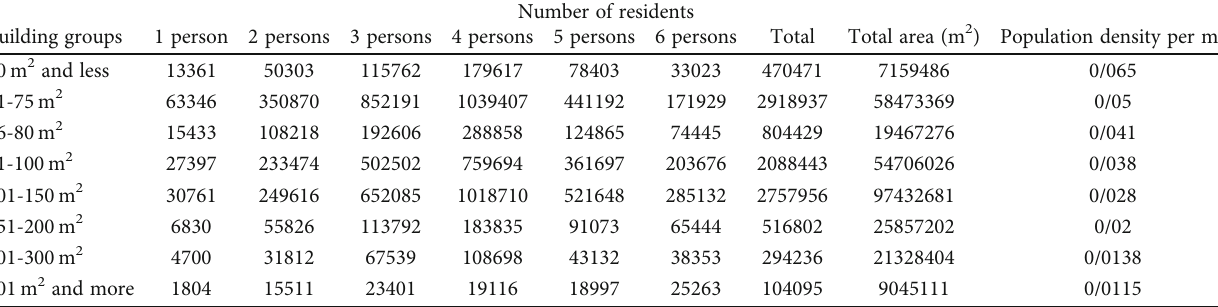
Table 4: Number and density of people in building groups.